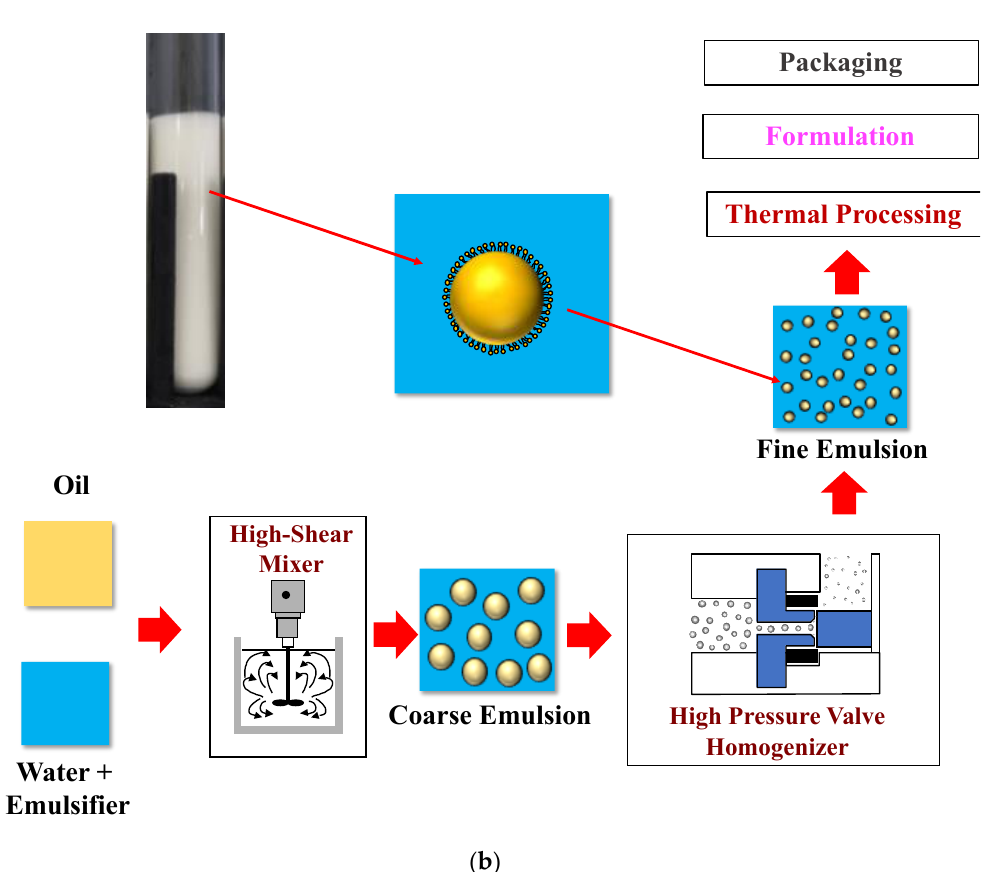
Figure 1. ( a ) Some commonly used processing operations that are utilized to produce plant-based milk substitutes. These processes need not be carried out in the order shown. Adapted from T. McHugh [17]. ( b ) Plant-based milk substitutes can also be produced by homogenizing plant-based oil and emulsifiers with water. Typically, a coarse emulsion is formed first, which is then passed through a homogenizer.